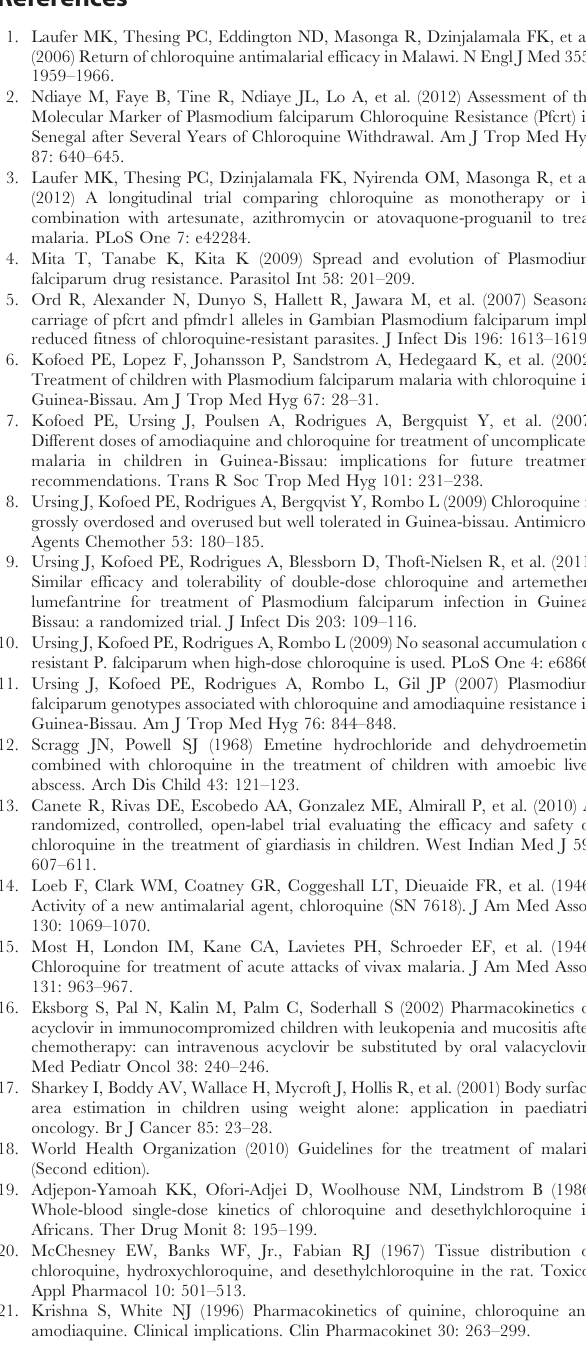
Table S1 Median and interquartile range whole blood desethyl chloroquine and chloroquine + desethyl chloro- quine concentrations (nmol/l) in different age